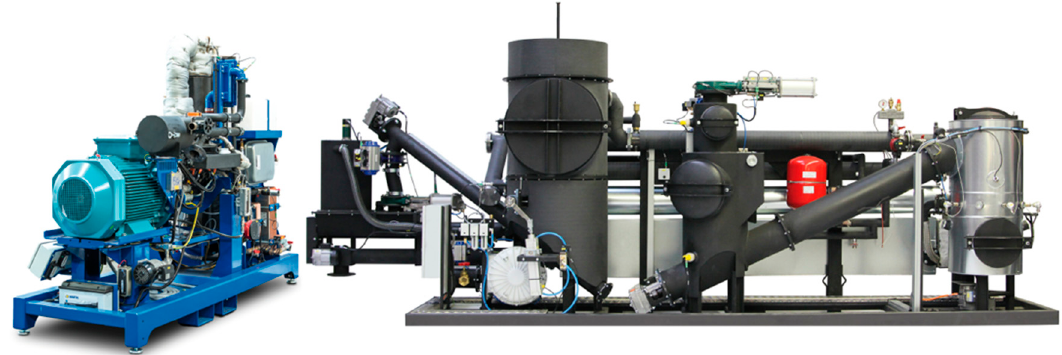
Figure 20. Electricity and heat from the Wood-Spanner Re 2 Gmbh system [25].